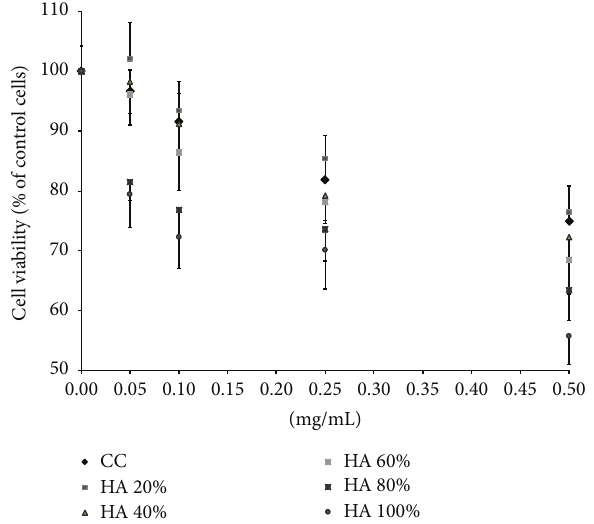
Figure 10: Effects of various composite powders modification (exchange of silica filer with HA whiskers %) on THP-1 cell viability. THP-1 cells were treated with different concentrations of HA or CC (0.05–0.5 mg/ml) for 48 h, and then cell viability was assessed by the MTT assay. Results are expressed as percentages of untreated cultures. Data are the mean ± SEM from five separate experiments. Statistically significant differences were evaluated by one-way ANOVA, followed by Newman-Keuls post hoc test. ∗ 𝑝 < 0.05 , ∗∗ 𝑝 < 0.01 , and 𝑝 < 0.001 significant differences in comparison to untreated